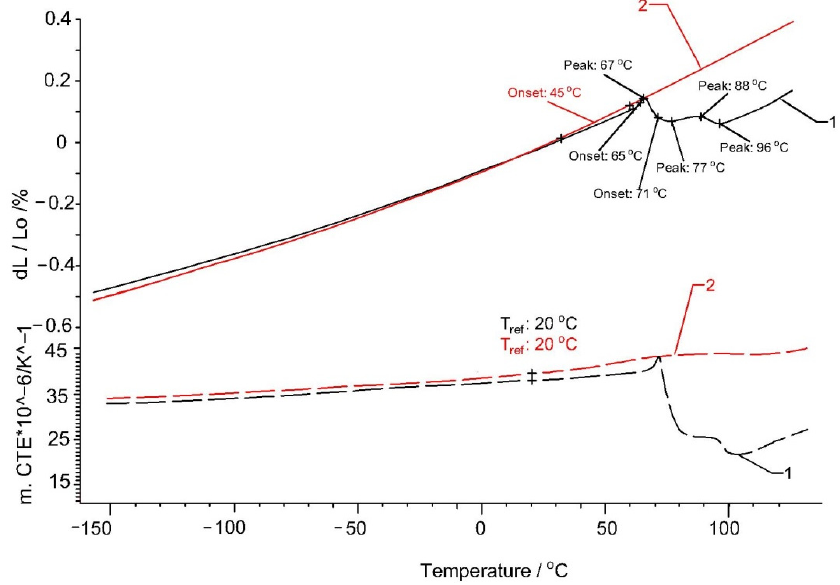
Figure 8. Thermal expansion (solid lines) and coefficient of thermal expansion of the samples Arboform ® LV3 Nature reinforced with aramid fiber: 1—first heating; 2—second heating.